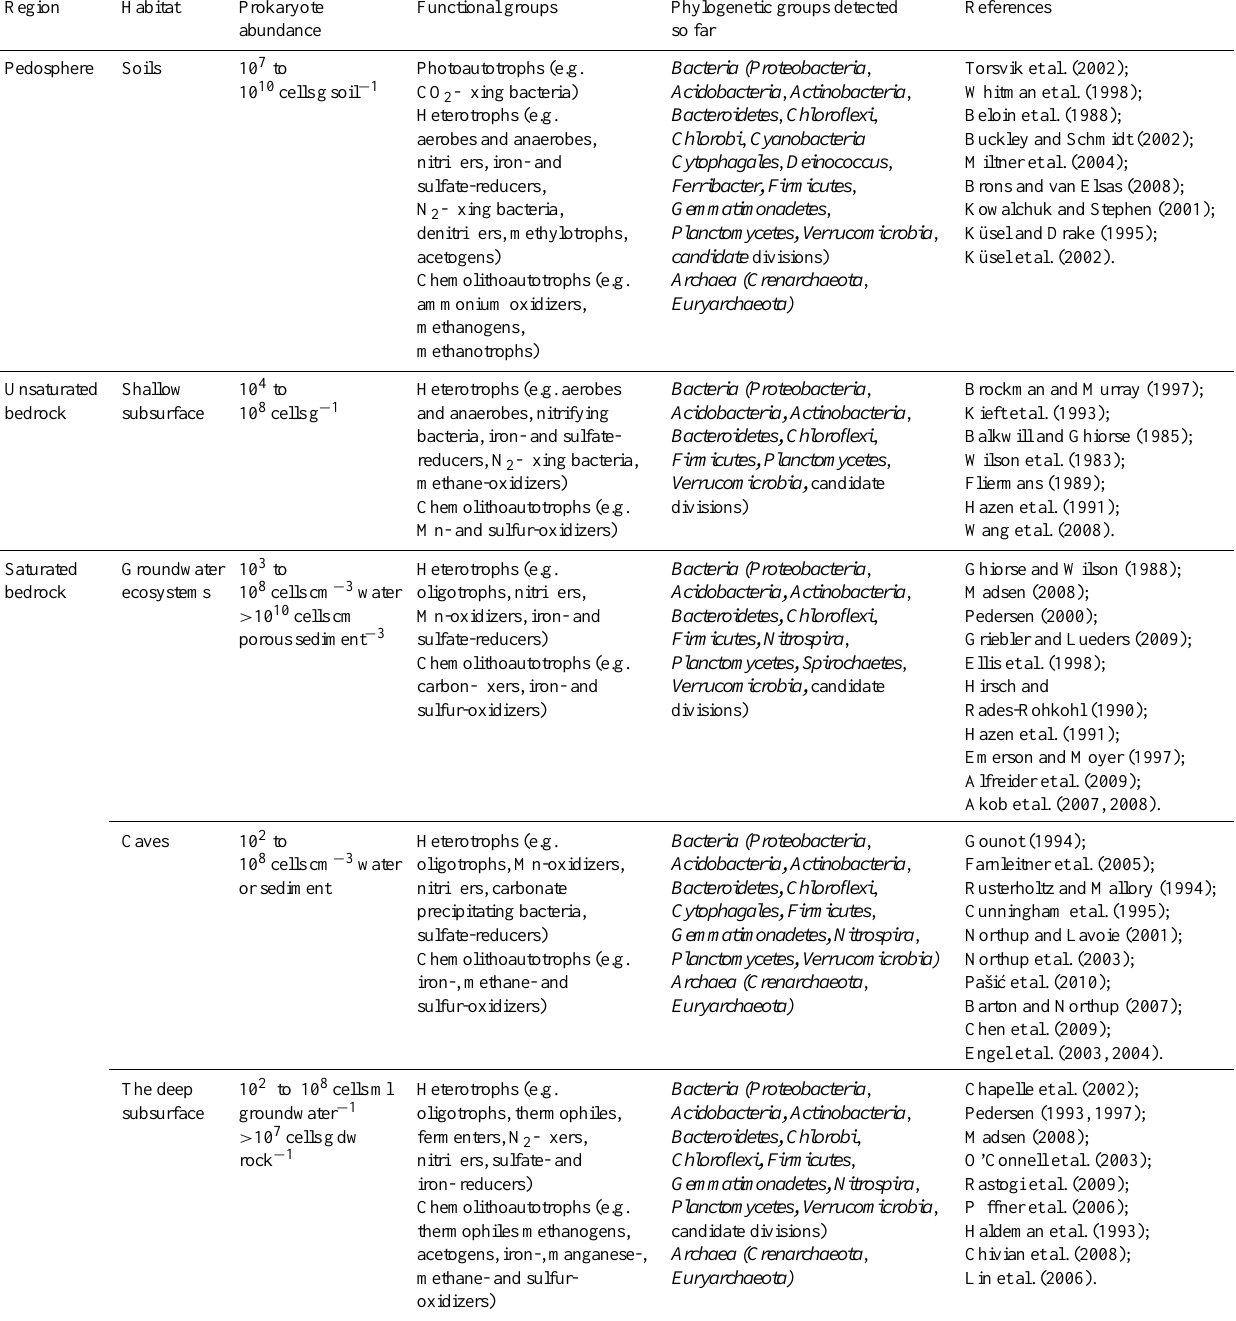
Table 1. Examples of prokaryote abundance, phylogenetic diversity, and functional role in CZ